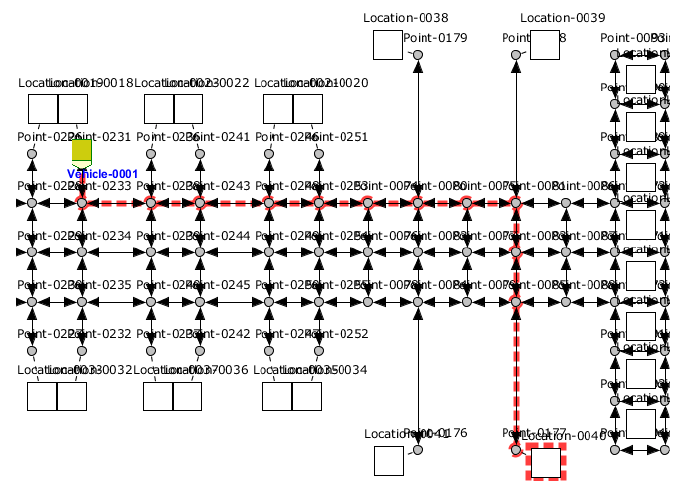
Figure 12. Paths planned by the first-level path planning algorithm.